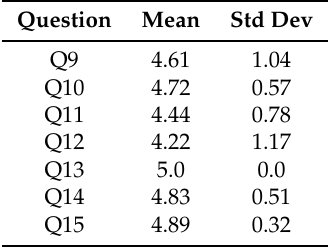
Table 7. The students’ satisfaction of questionnaire result of the R-WOSARLS in the experiment